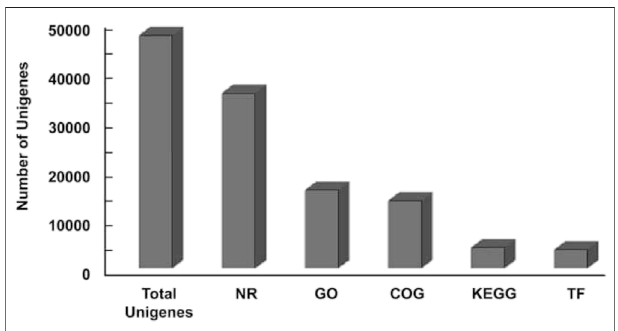
FIGURE 4 | Summary of annotation of all